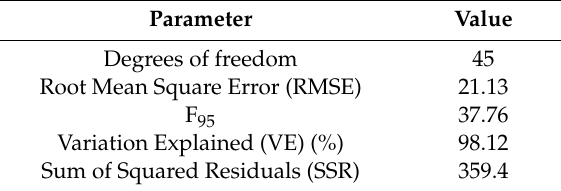
Table 3. Statistical parameters obtained from fitting experimental data to proposed kinetic